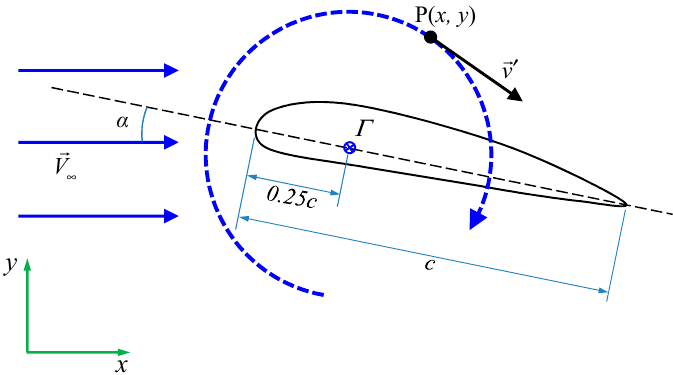
Figure 2. Illustration of the concentrated vortex of an